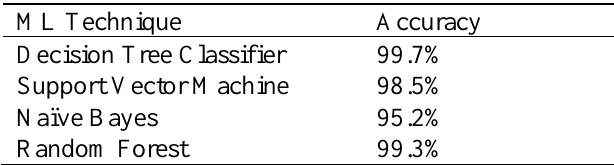
Measurements of performances for all features ML